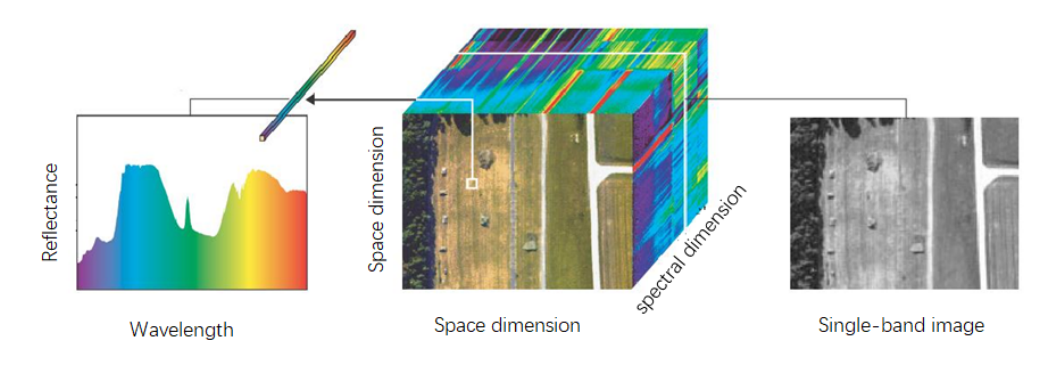
Figure 1. Three-dimensional structure of hyperspectral